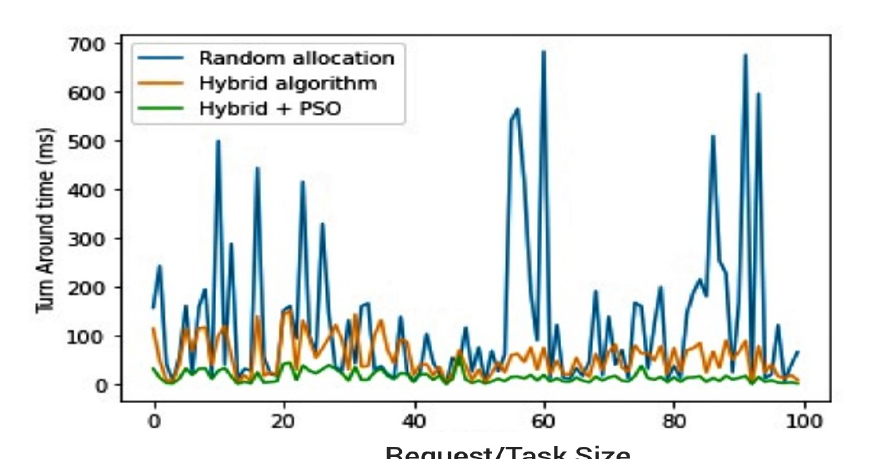
Figure 11. Random resource allocation vs. hybrids resource allocation vs. PSOR2B.